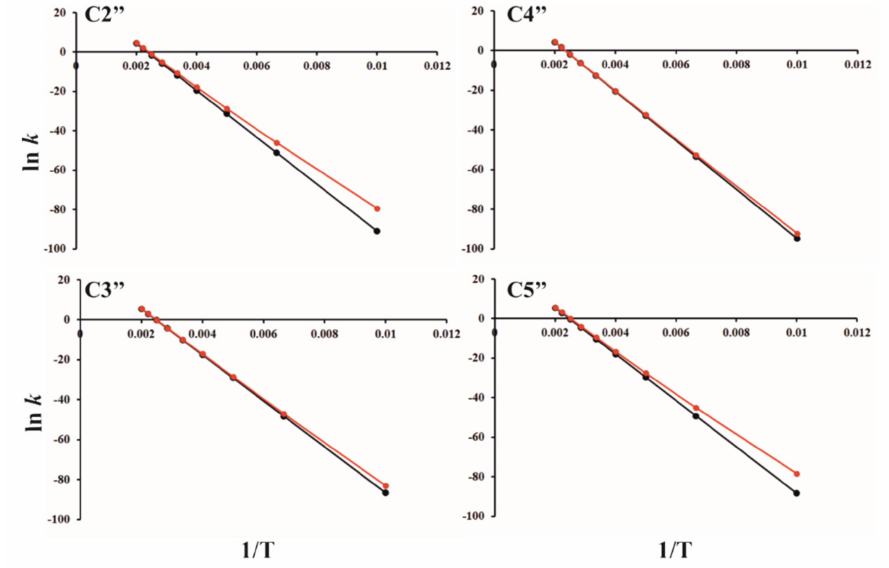
Figure 9. Dependence of ln k TST (black) and ln k ZCT_0 (red) on reciprocal temperature for